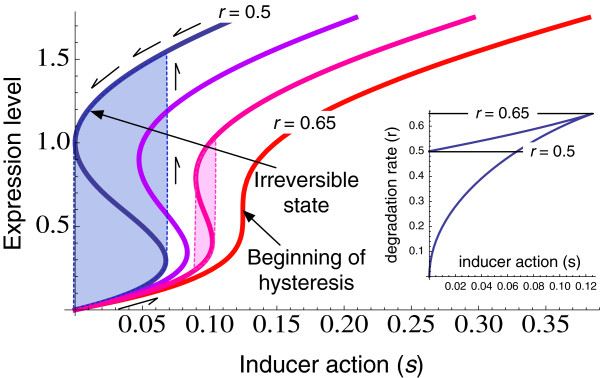
Hysteresis in the dynamical system. Figure shows the solutions for the gene expression level (x) as a function of r and s. Inset shows the region of bistability. For values of r between 0.65 and 0.5, the hysteretic behavior is reversible. For r<0.5, the system can get irreversibly locked into the ON state.